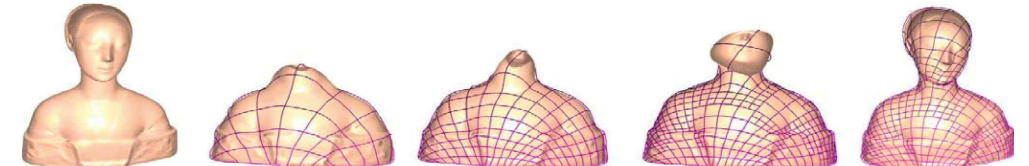
Figure 6: A model of the polynomial splines with control nets.